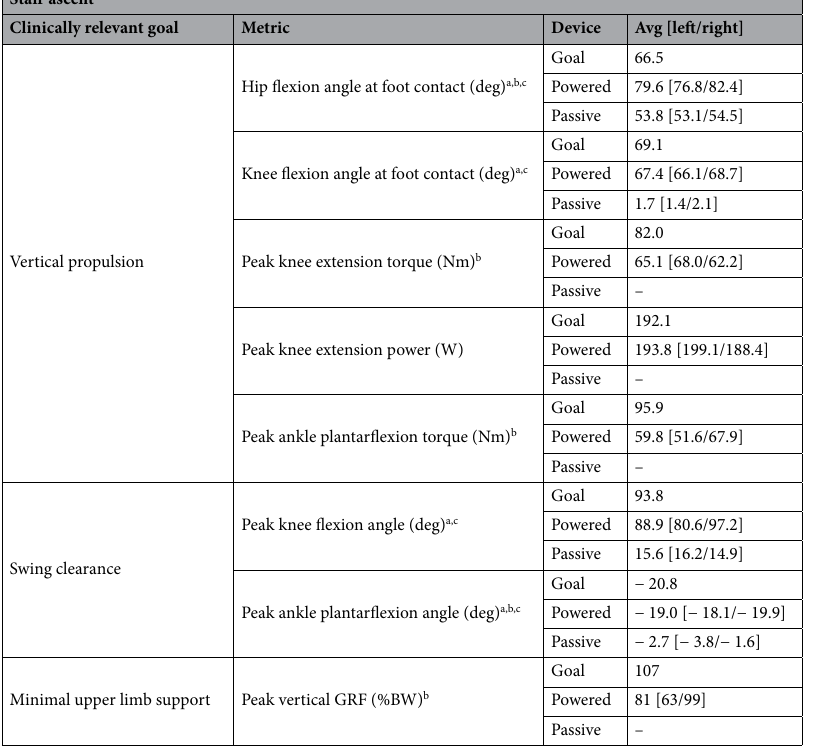
Table 2. Clinically relevant goals and metrics during stair ascent for the powered and passive prostheses. a Statistically significant difference between powered and passive prostheses. b Statistically significant difference between powered prostheses and nonamputee reference. c Statistically significant difference between passive prostheses and nonamputee